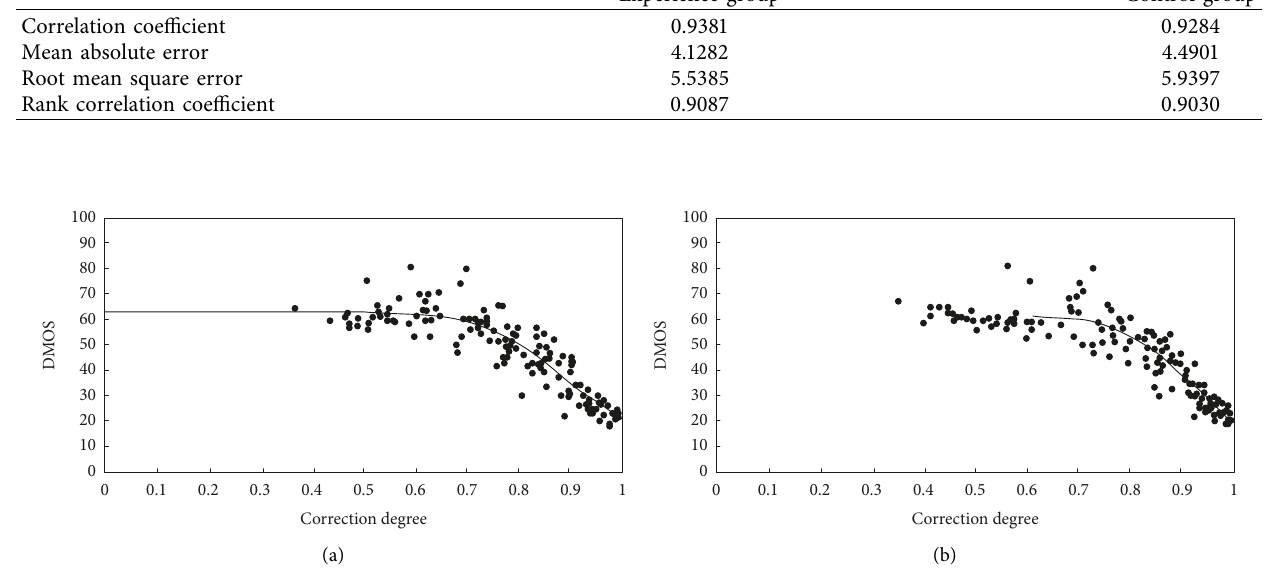
Figure 7: Edge correction scatter of JPEG distorted image. (a) Control group. (b) Experience